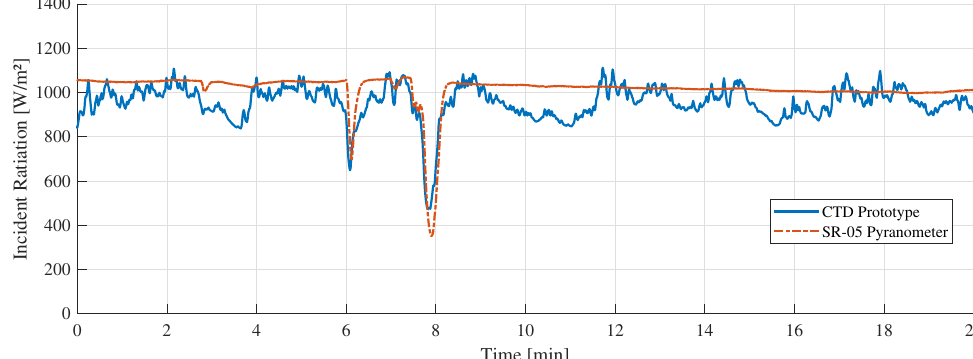
Figure 11. “A” measurement with clear sky weather conditions.